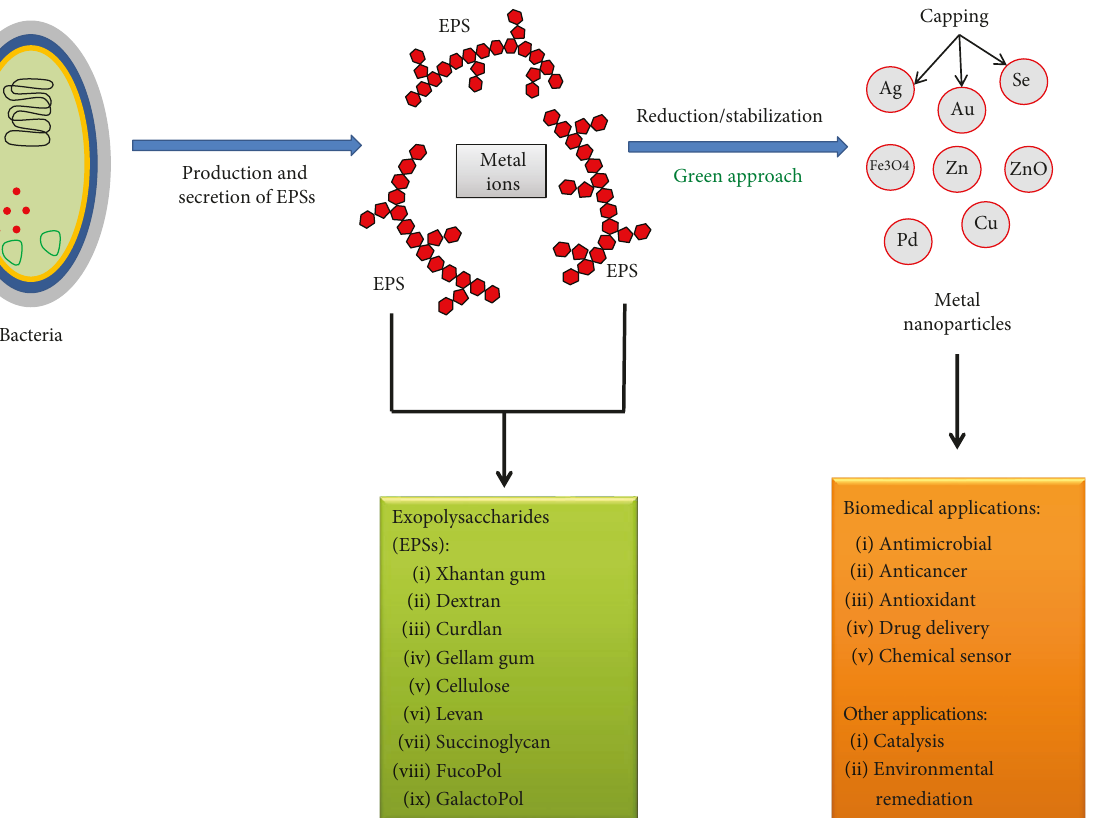
Figure 4: Summary of the content of this